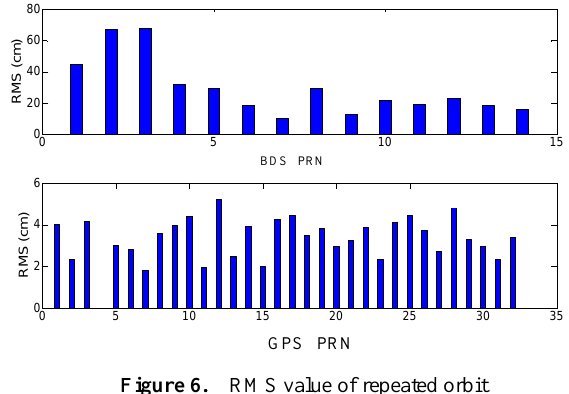
Figure 6 ． RMS value of repeated orbit at the junction of days